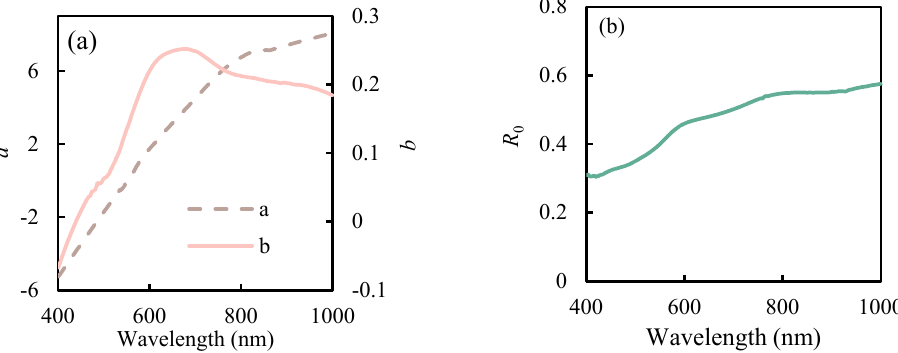
Figure 9. Calibration results of parameters a , b and R 0 in the soil spectral reflectance exponential model: ( a ) parameters a and b ; ( b ) R 0 .